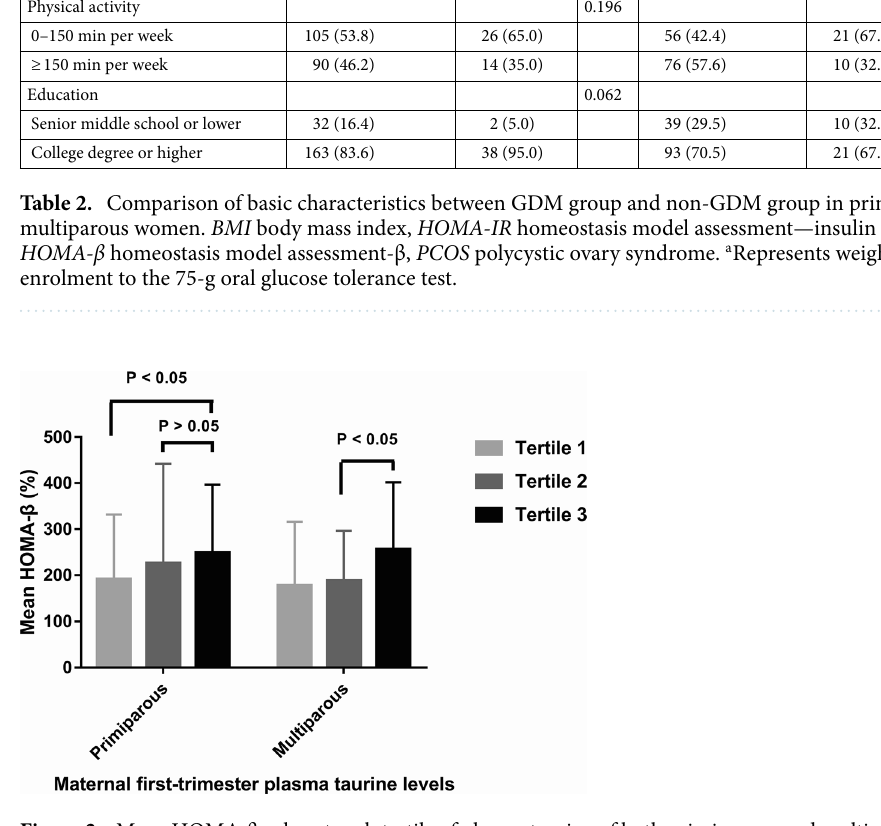
Figure 2. Mean HOMA-β value at each tertile of plasma taurine of both primiparous and multiparous